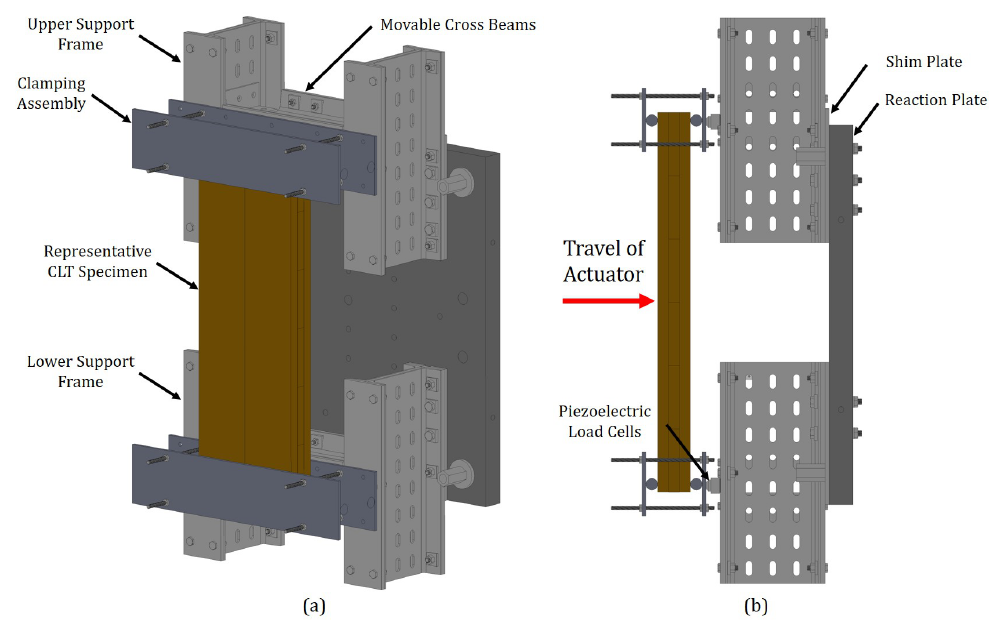
Figure 5. Supporting reaction frame design: ( a ) perspective view, ( b ) side view.